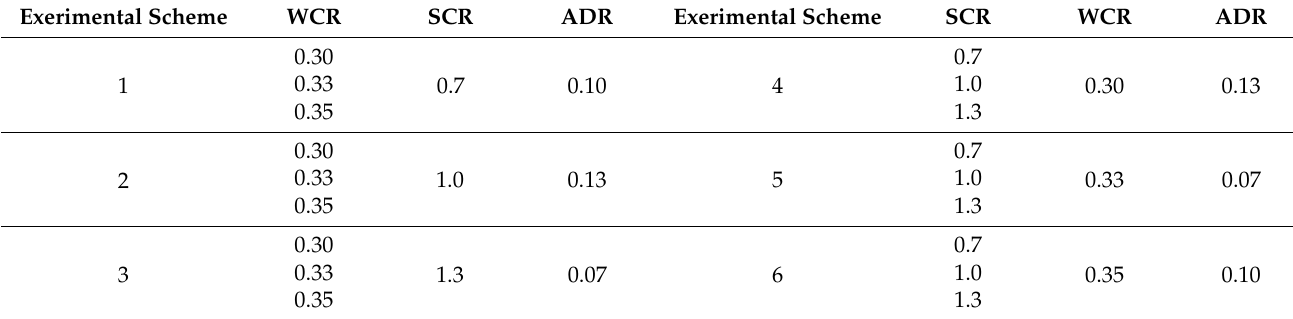
Table 3. Experimental